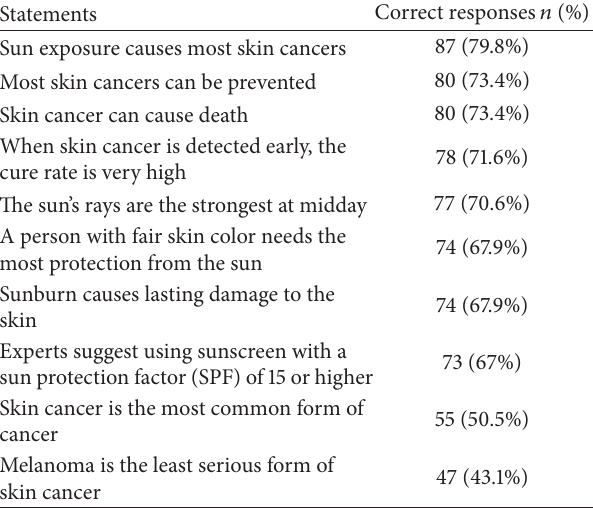
Table 3: Frequencies and percentages of correct responses to knowledge of skin cancer (descending